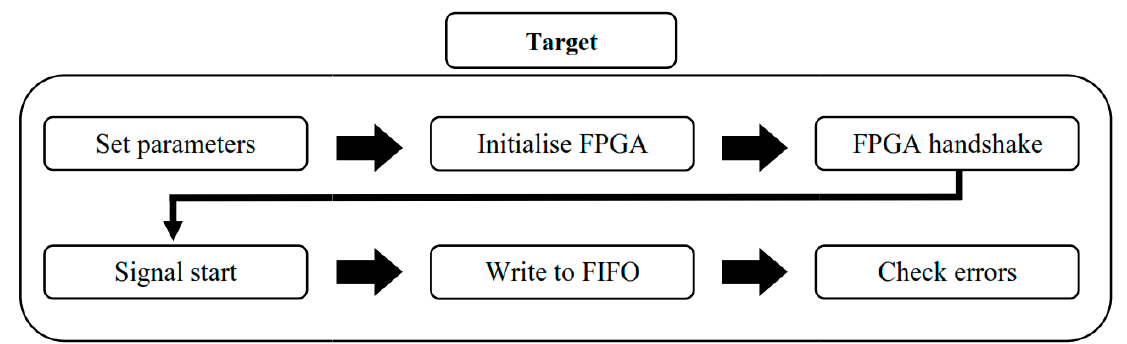
Figure 2. Programme function flowchart of the designed target code, which is compiled on board the cRIO, to collect and stream the accelerometer data to the host computer.